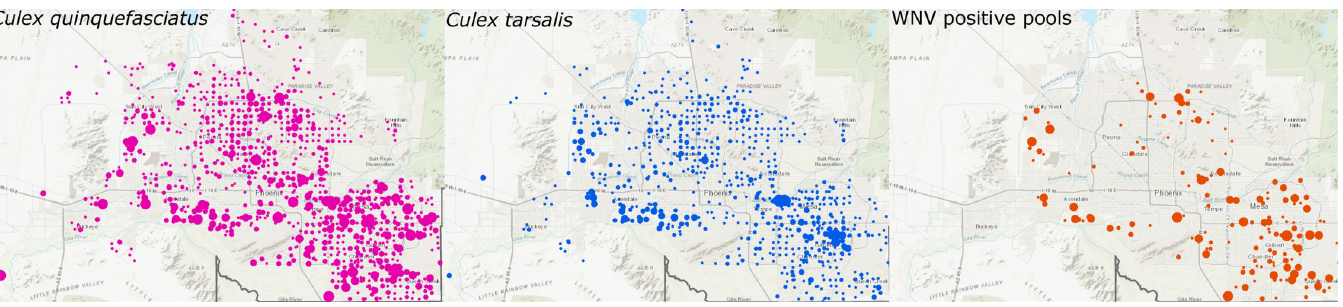
Fig 1. Distribution of WNV and its vectors across Maricopa County in 2017. The dots represent the count of individual female Culex quinquefasciatus (left), Culex tarsalis (center), or WNV positive mosquito pools (right) at each of 787 carbon dioxide traps distributed primarily throughout the urban portion of the county. Larger circles indicate a higher density at a particular trap. The USGS Topo was used as a basemap for this figure (USGS The National Map: National Boundaries Dataset, National Elevation Dataset, Geographic Names Information System, National Hydrography Dataset, National Land Cover Database, National Structures Dataset, and National Transportation Dataset; U.S. Census Bureau—TIGER/Line; HERE Road Data. Data Refreshed July, 2017). The final map was created using ArcGIS software by Esri. ArcGIS and ArcMap are the intellectual property of Esri and are used herein under license. Copyright Esri. All rights